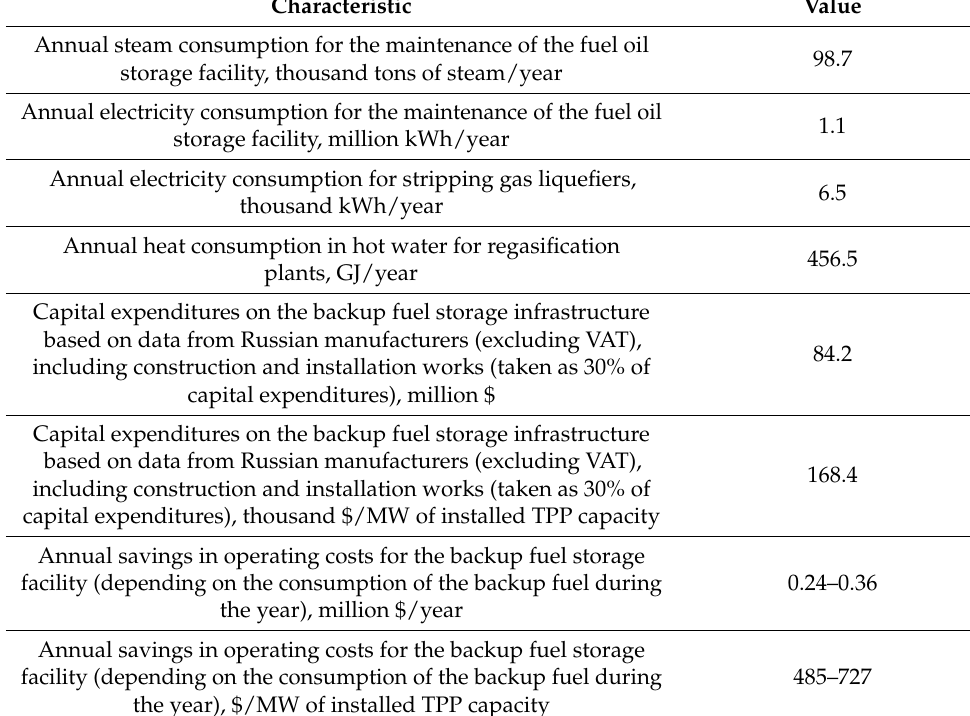
Table 10. Characteristics of the measure for the replacement of the fuel oil storage facility of TPP with the LNG and hydrogen storage